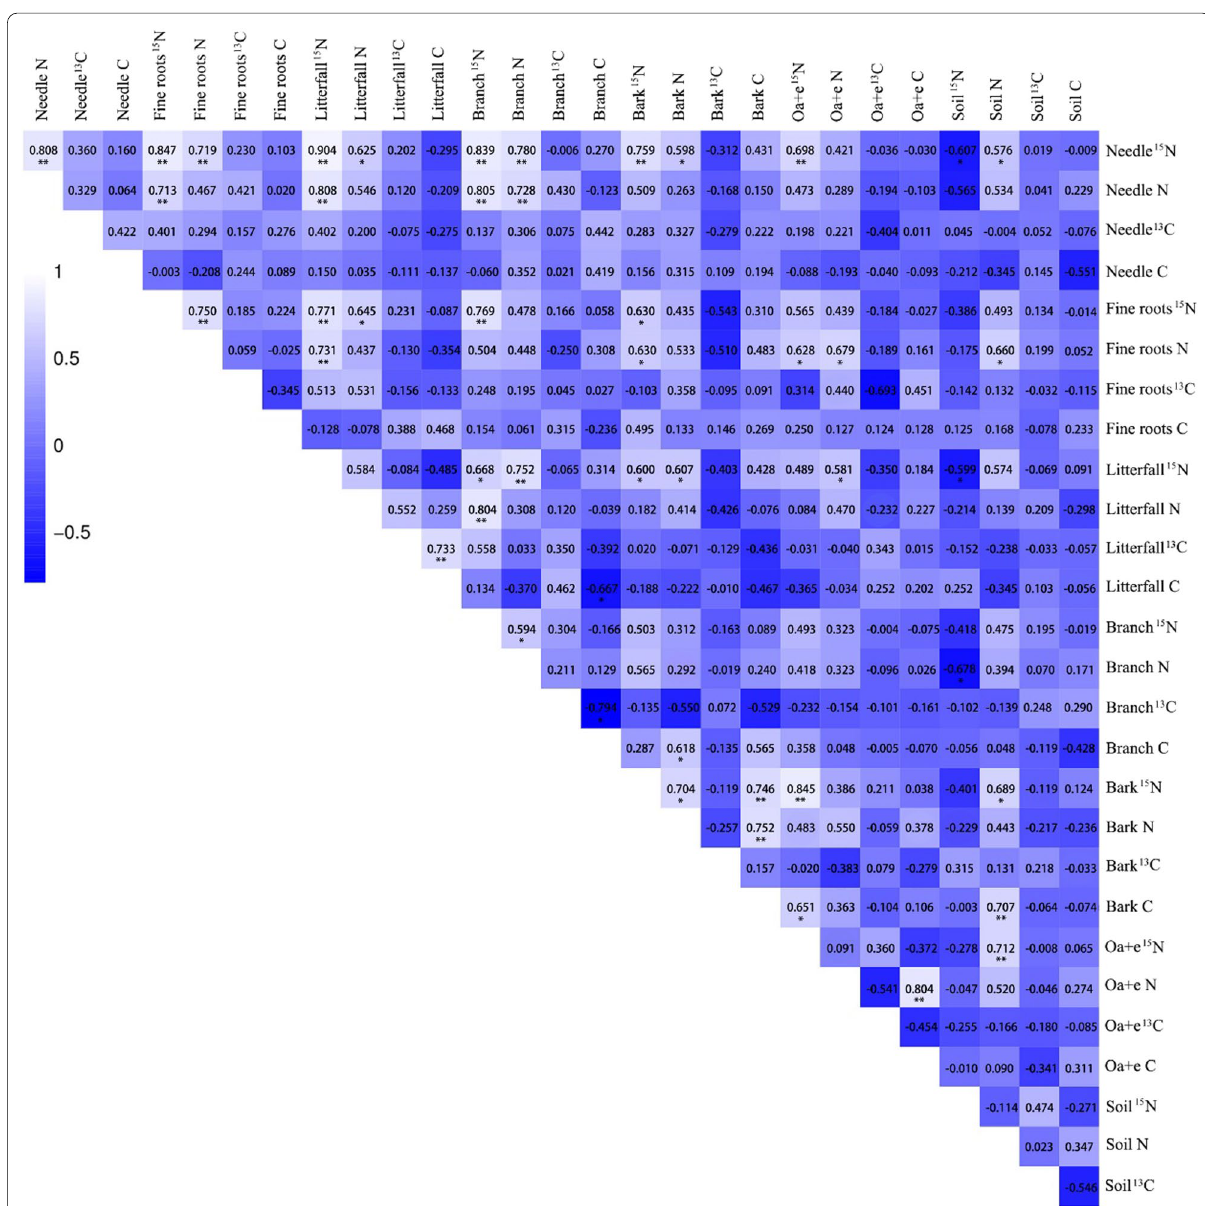
Fig. 5 Pearson correlation coefficients among the C, N, δ 13 C, and δ 15 N of different compartments of Larix gmelinii and soil . * represents p < 0.05, ** represents p <